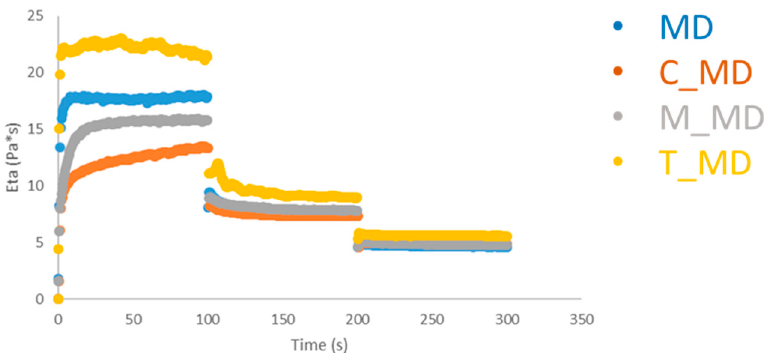
Figure 6. Step Rate muffin dough at 15 °C. MD = muffin dough without baking; T_MD = muffin dough